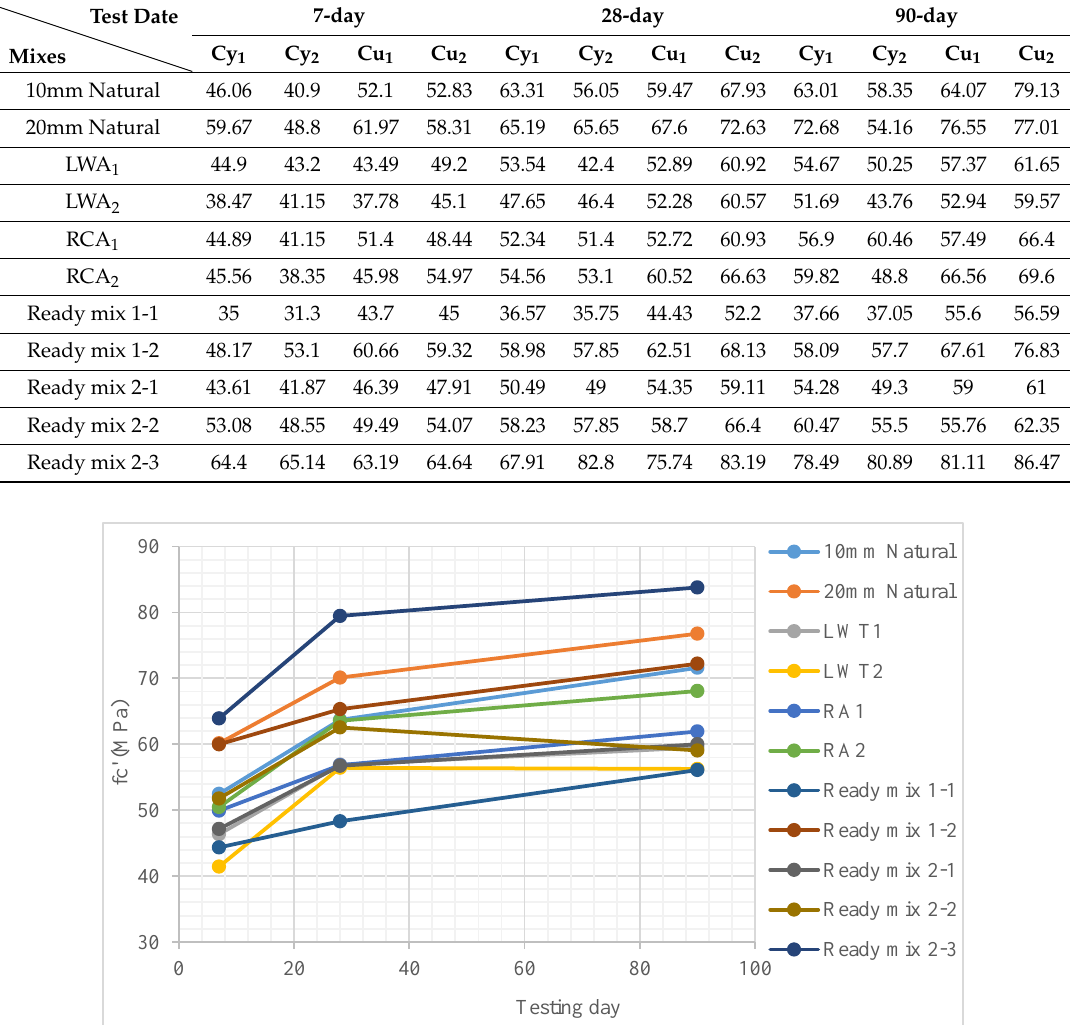
Table 6. Summary of the experimental investigation. Test